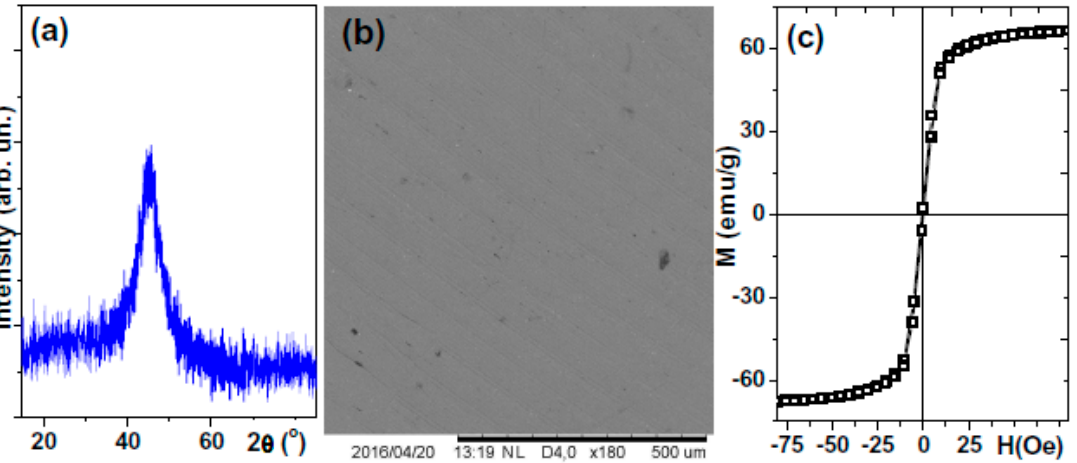
Figure 3. Selected properties of Co 68.6 Fe 3.9 Mo 3.0 Si 12.0 B 12.5 amorphous ribbons: XRD patterns ( a ); surface morphology, SEM ( b ) and VSM hysteresis loop measured at room temperature ( c